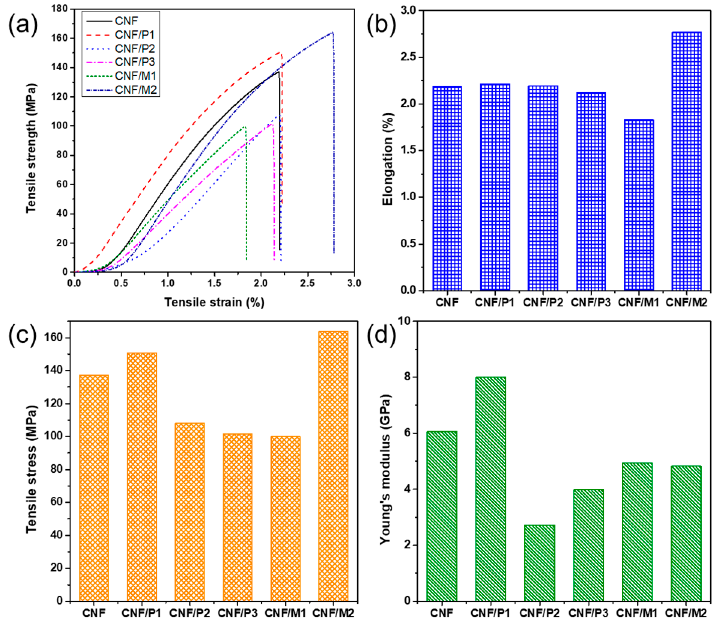
Figure 3. Mechanical properties of pure CNF film and different composite films. ( a ) Stress–strain curve; ( b ) Elongation to break; ( c ) Tensile stress; ( d ) Young’s modulus. curve; ( b ) Elongation to break; ( c ) Tensile stress; ( d ) Young’s